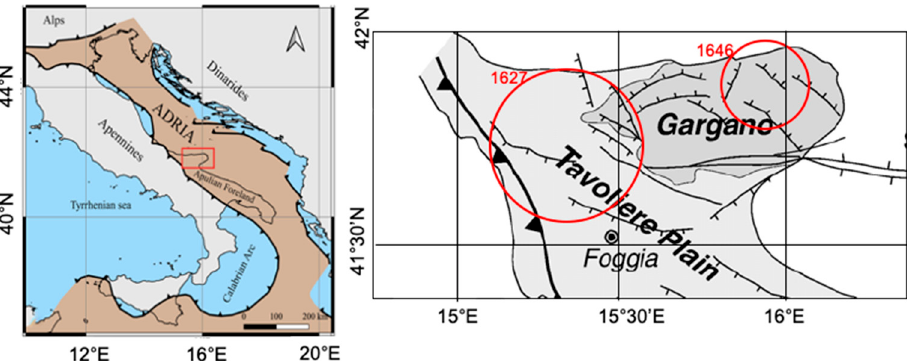
Figure 1. Left : Seismotectonic map of Italy (modified after [30]); the red rectangle marks the study area. Right : detail showing the geological lineaments of the GP. The red circles represent the estimated focal volume of the two major historical earthquakes (modified after [29]).